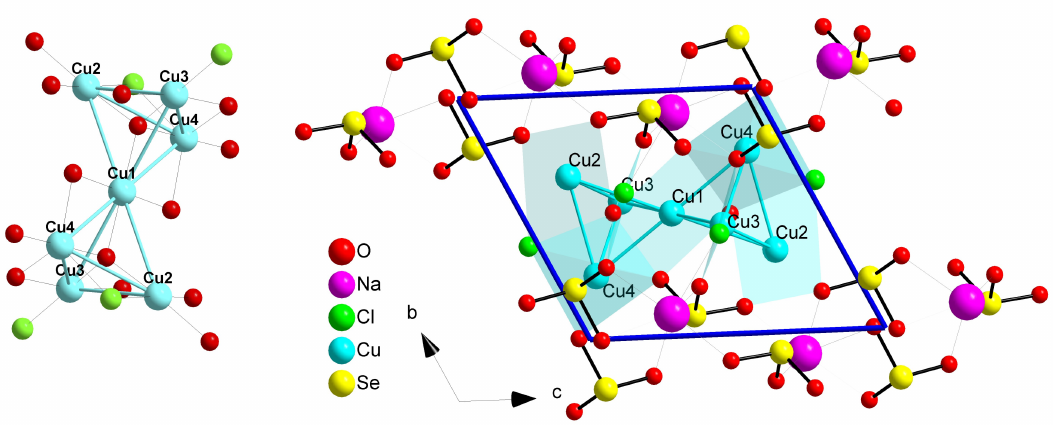
Figure 22. [Cu 7 O 14 Cl 4 ] 18 − cluster (left) and the copper polyhedra with SeO 32– groups in the crystal structure of Na 2 Cu 7 (SeO 3 ) 4 O 2 Cl 4 (right)